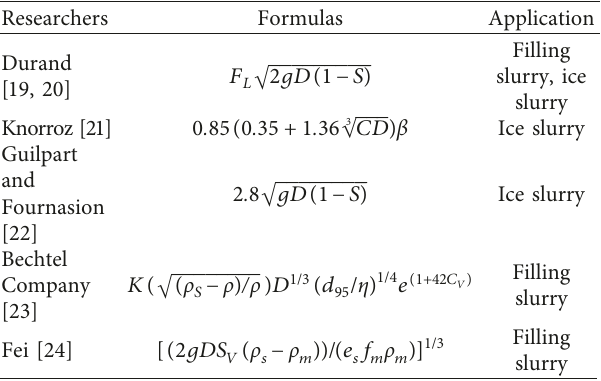
Table 2: The critical velocity formulas of